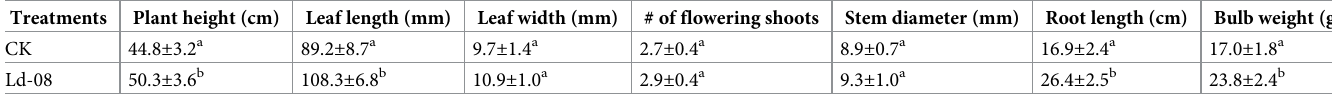
Means are averages ± standard deviations (SD). Values in a column with different letters are significantly different (P-value � 0.05) according to ANOVA and student´s t-test with Bonferroni´s correction for multiple comparisons.